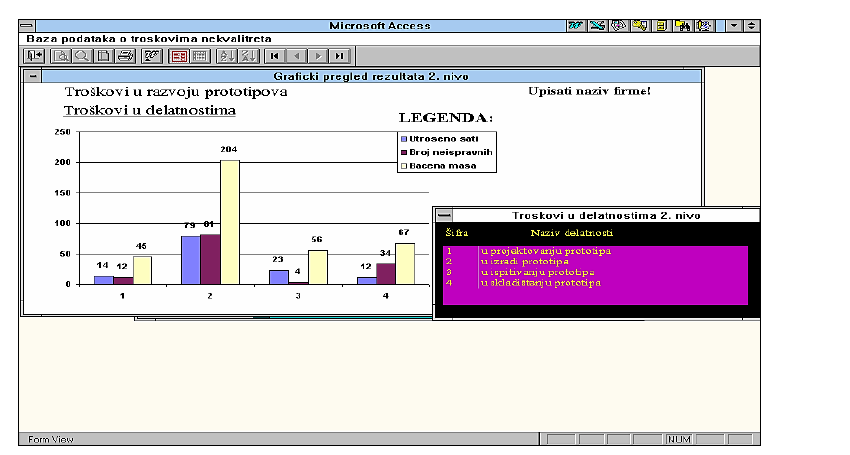
Figure 14 – Example of the window for search of the nonconformities costs at level 2 Рис . 14 – Пример окна для поиска затрат по дефектам на уровне 2 Слика 14 – Пример прозора за прегледање трошкова неисправности на 2.